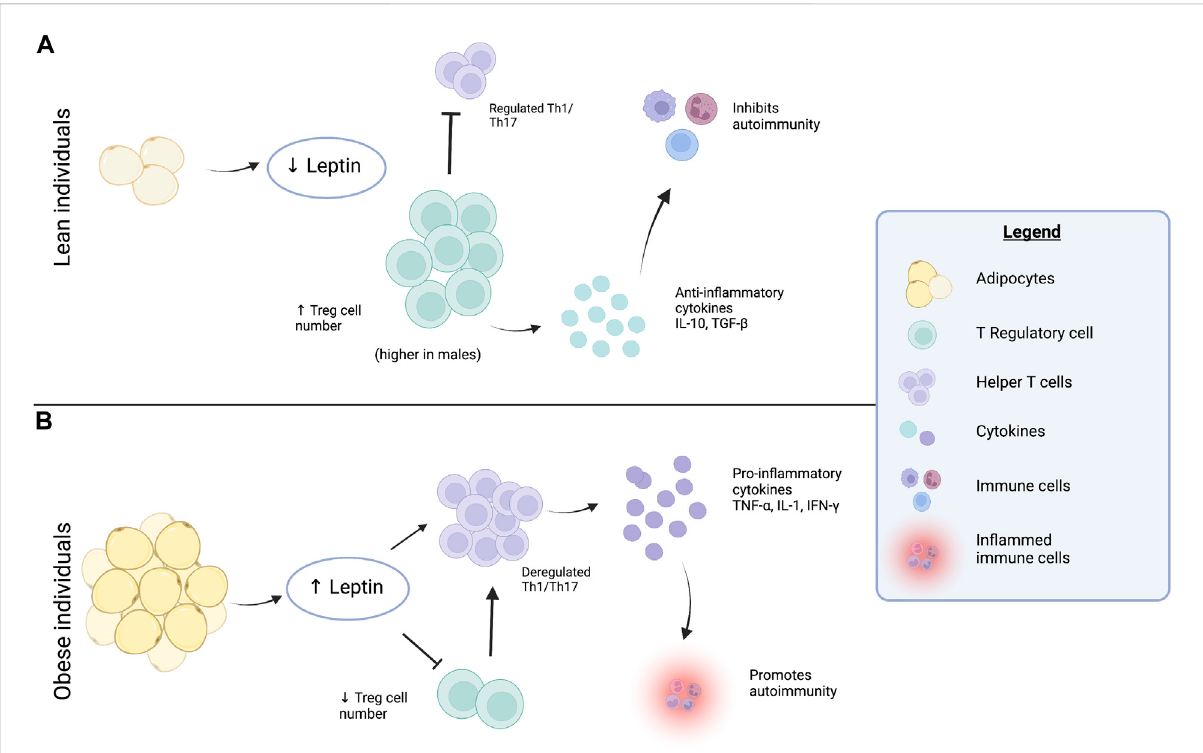
Contributions of the adipokine leptin to adipose tissue in fl ammation. (A) In lean individual ’ s — adipocytes secrete lower amounts of the adipokine, leptin. Lower levelsofleptin are considered protective against pro-in fl ammatorypathwayactivation and associated with aregulated Th1/ Th17 response and higher numbers of Treg cells in adipose tissue, particularly in males. This leads to secretion of anti-in fl ammatory cytokines IL-10 andTGF- β ,thatinhibitandprotectagainstmechanismsthatcauseautoimmunity. (B) Inobeseindividuals — adipocytessecretehigheramounts of leptin, which reduces the number of Treg cells and ultimately causes a dysregulated Th1/Th17 response. The Th1/Th17 cells secrete pro- in fl ammatory cytokines TNF α , IL-1 and IFN- γ , which promotes autoimmune disease development and dysregulated tissue in fl ammation. Created with